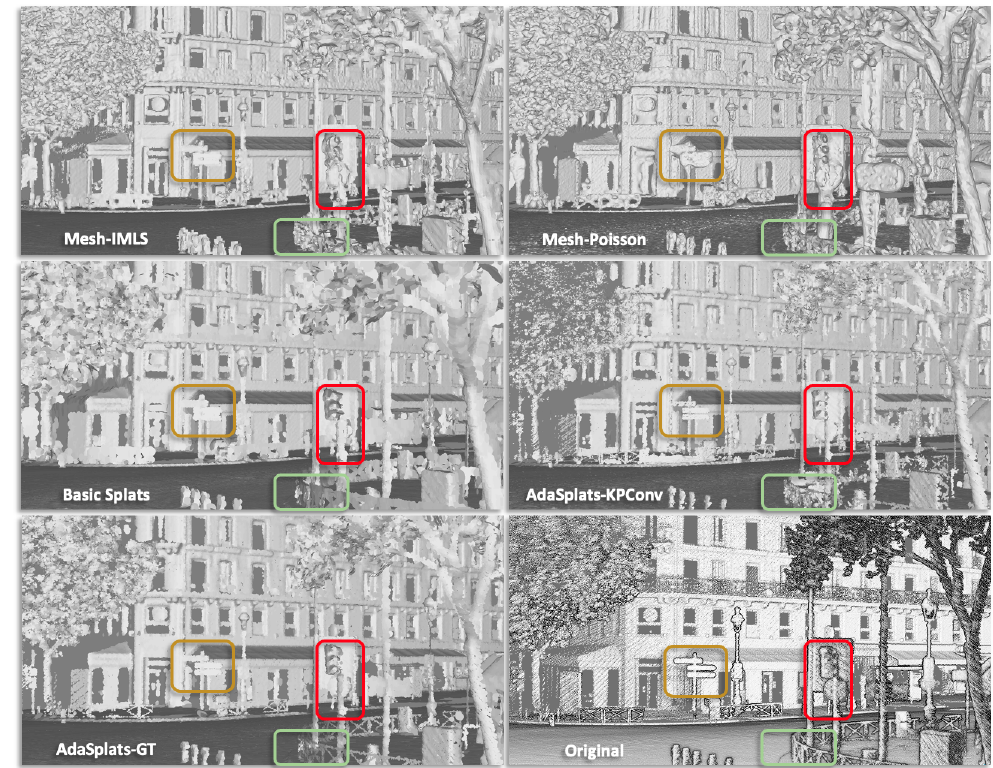
Figure 8. Rendering the different surface representations on PC3D-Paris. The top row shows the meshed scene using IMLS (left) and Poisson (right). The middle row shows the splatted scene using basic splats (left) and AdaSplats using KPConv semantics (right). The bottom row shows the splatted scene using AdaSplats-GT, which contains the ground truth point-wise semantic information (left) and the original point cloud (right). We show the ability of AdaSplats to recover a better geometry, especially on fine structures (in green, red and yellow